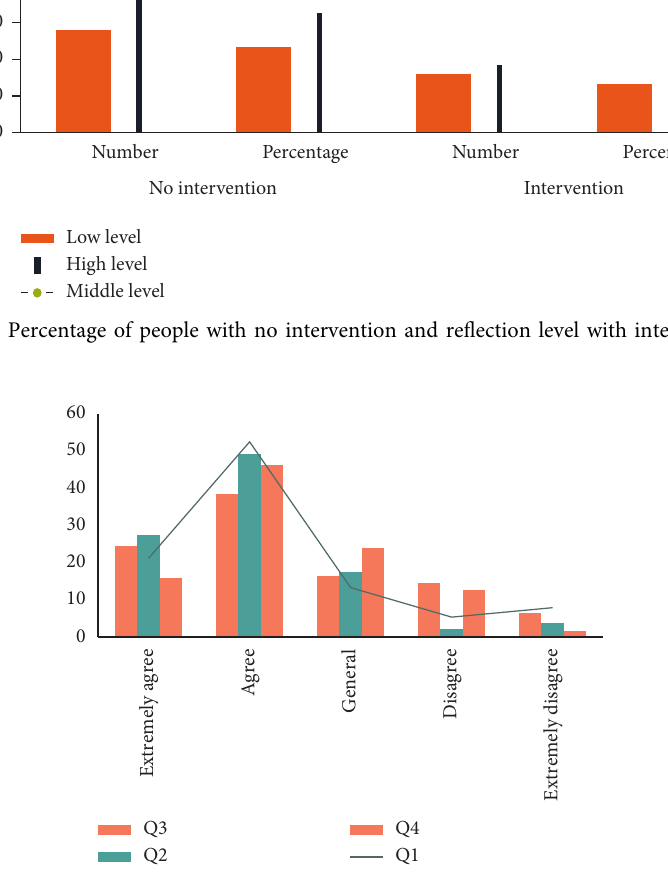
Figure 7: The statistical table of the overall satisfaction survey questionnaire of teaching